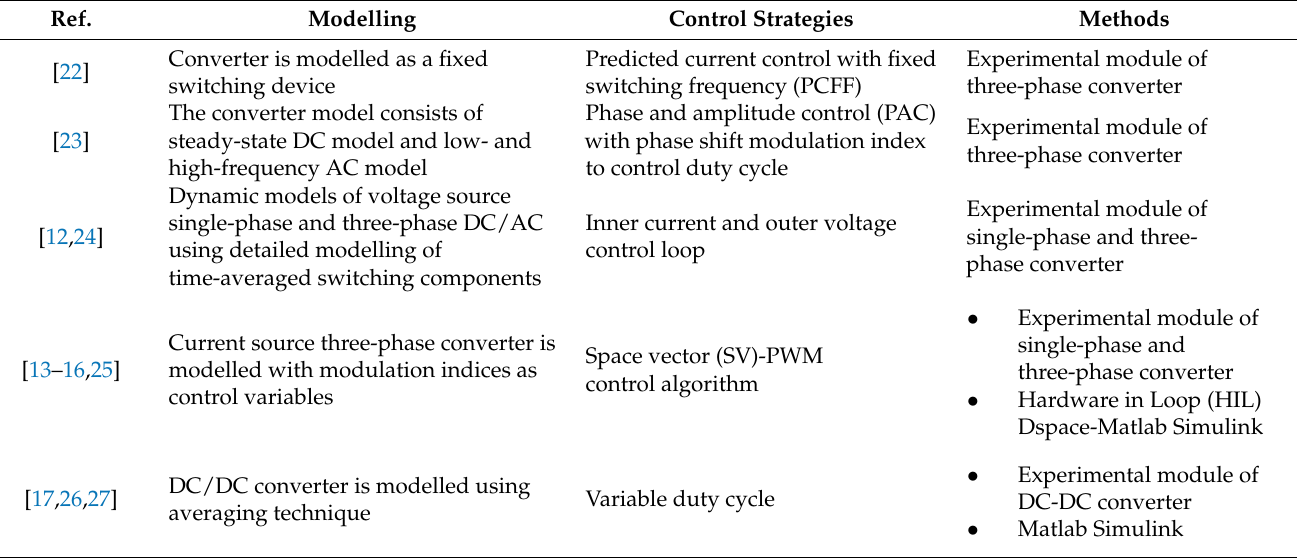
Table 2. Small-signal model of power electric